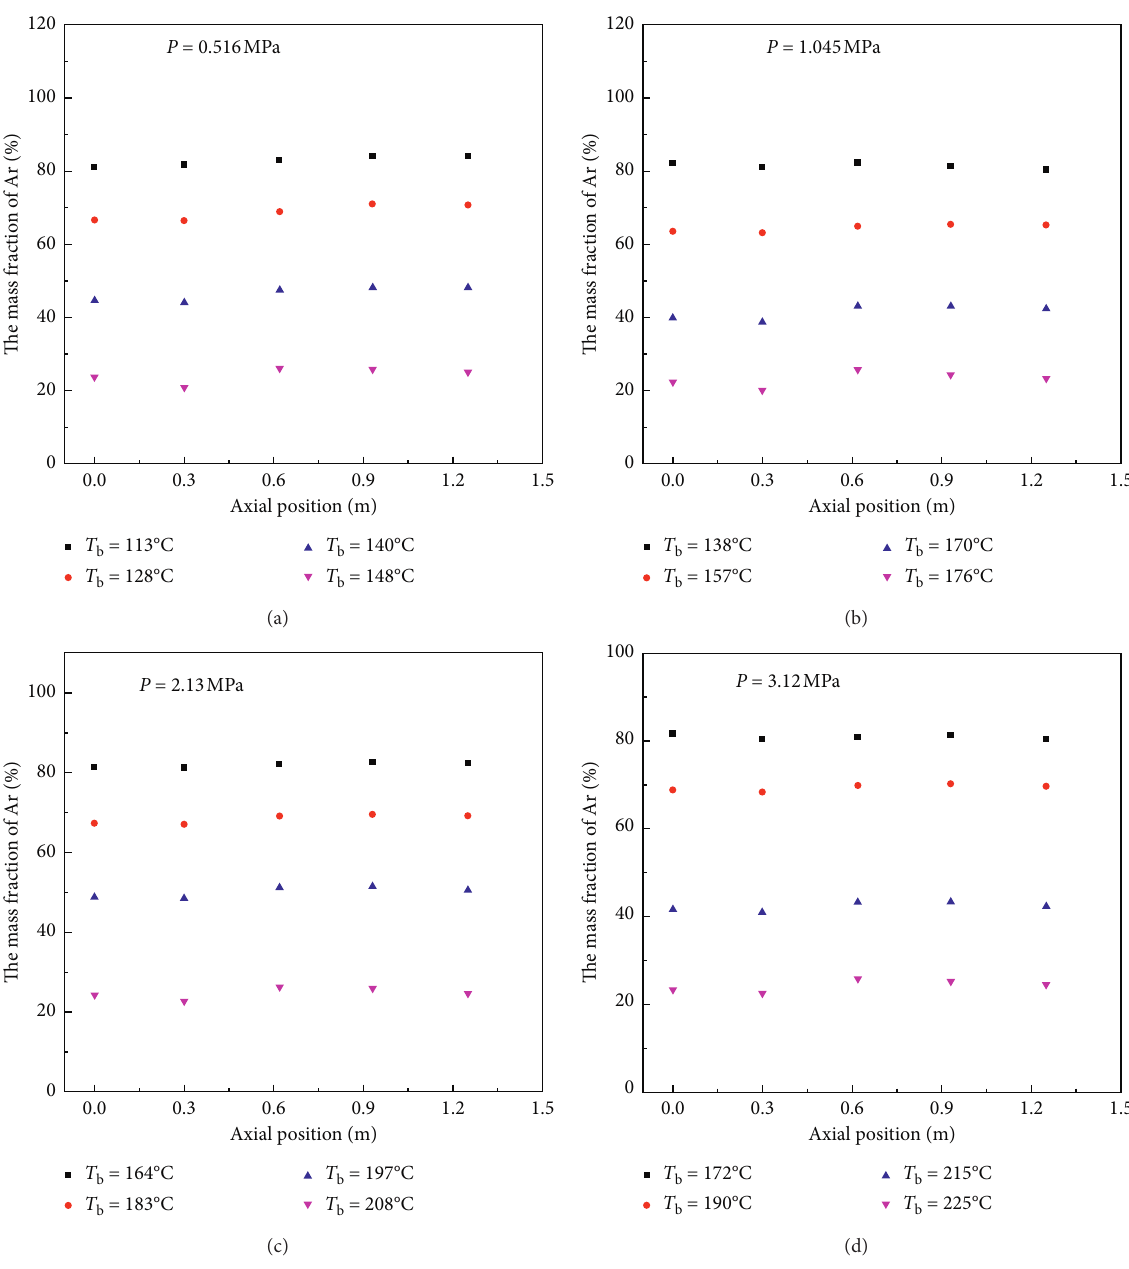
Figure 4: The distributions of Ar in the axial direction. (a) P � 0.516 MPa. (b) P � 1.045MPa. (c) P � 2.13MPa. (d) P � 3.12